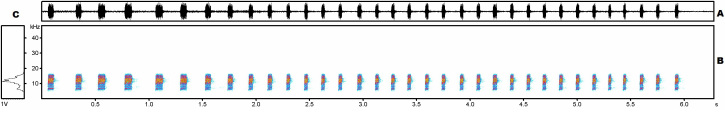
Calling song profile of a Tettigettalna
mariae specimen recorded in Cartaya (Huelva, Spain). A - Oscillogram (amplitude vs. time), B - sonagram or spectrogram (frequency vs. time) and C - mean amplitude spectrum (frequency vs. amplitude).